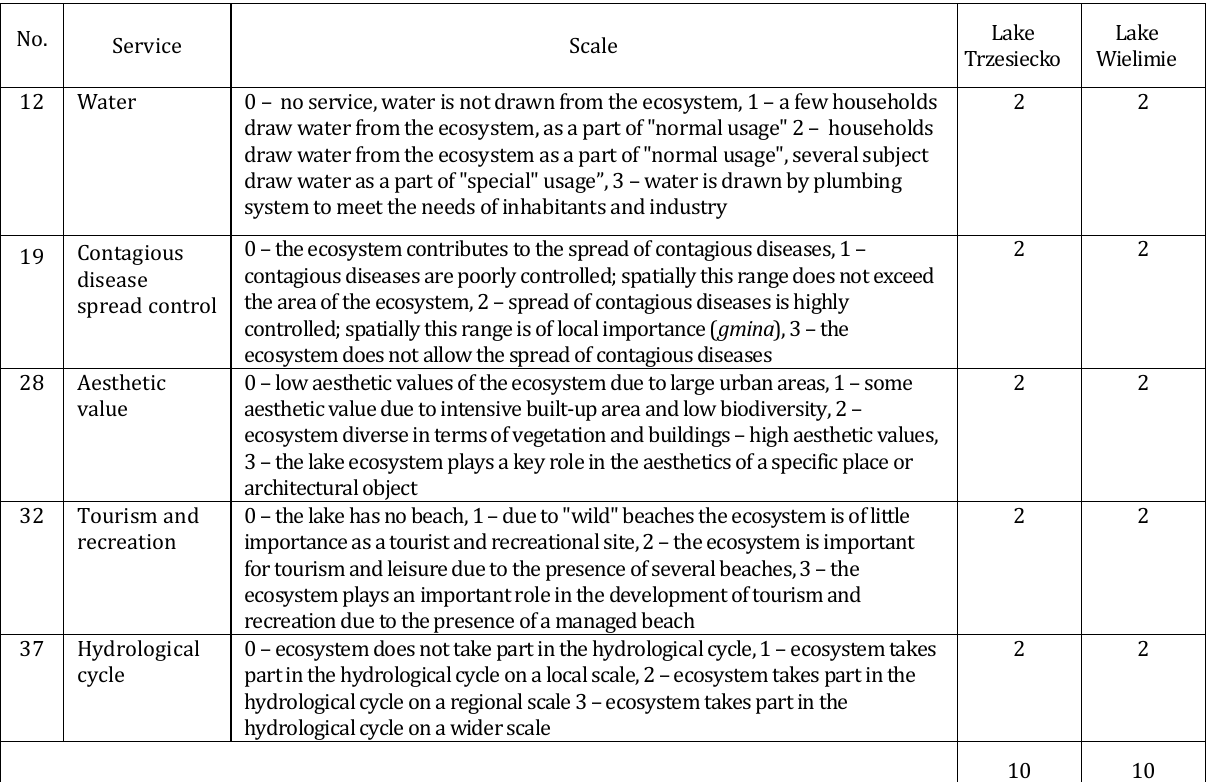
Table 3. Pre-valuation of ecosystem services of Lakes Trzesiecko and Wielimie (based on Bernaciak & Cichoń,